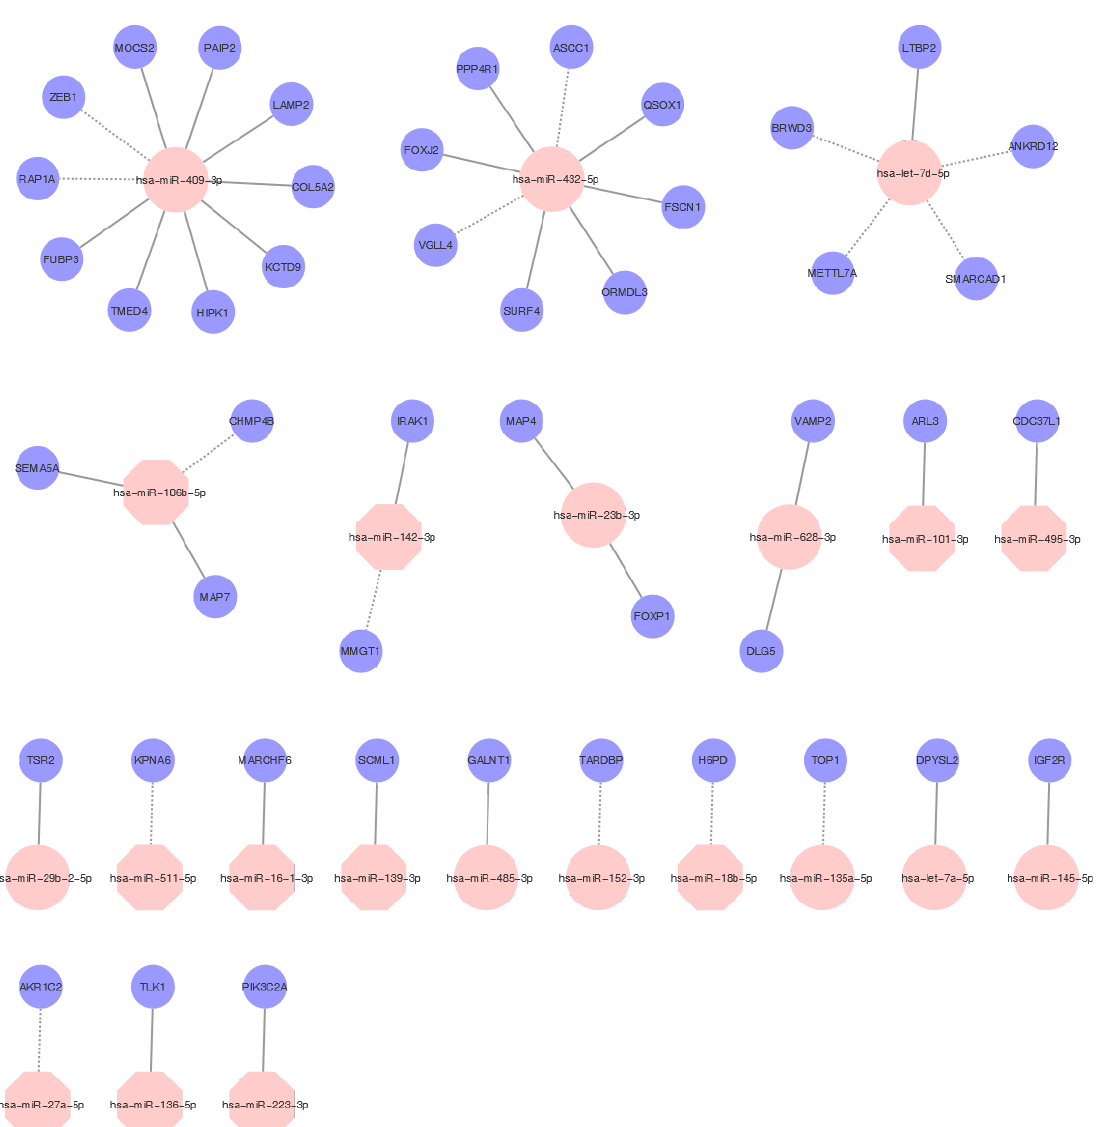
Figure 2. MiRNAs regulatory network. Examples of flexible and selective regulatory networks between miRNAs and mRNAs in samples after LVAD support. Selected overexpressed miRNAs are highlighted in pink circles, and underexpressed miRNAs are highlighted in pink octagons. The targets are highlighted in blue circles. The full line indicates a positive correlation, and the discontinued line indicates a negative correlation with target mRNAs.